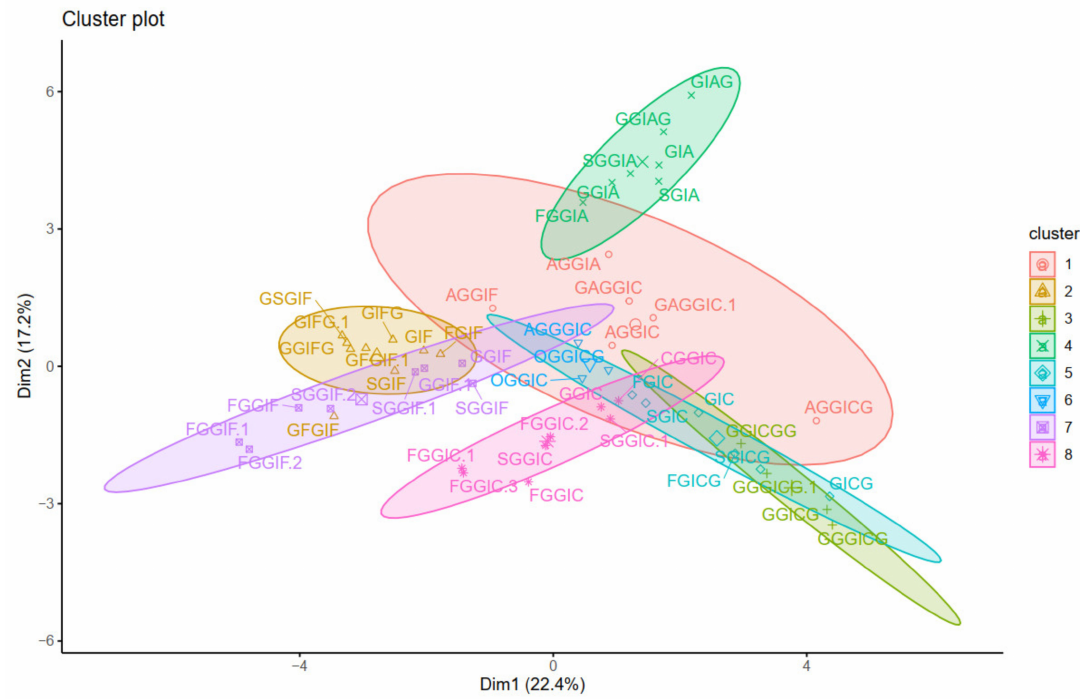
Figure 6. Visualization of the k -means clustering.